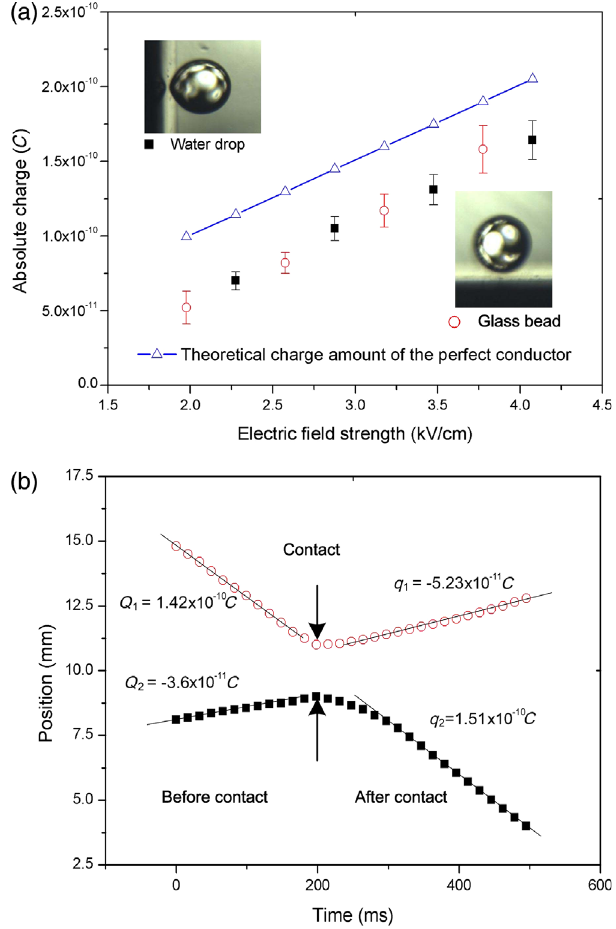
FIG. 1. Experiments within silicone oil: (a) Absolute value of the charges of a glass bead ( r ¼ 1 mm) and a water drop ( r ¼ 1 mm), bouncing between two high-voltage metal electro- des, after contact with the electrodes versus electric field strength (symbols). The charges are estimated from a balance between the viscous drag and Coulomb forces, while the solid line displays the theoretical charge of a perfectly conducting sphere ( r ¼ 1 mm) [39]. (b) Positions relative to the cathode and charges of two glass beads colliding between two high-voltage metal electrodes ( E ¼ 2 . 5 kV = cm) before and after their collision ( Q 1 þ Q 2 ≈ q 1 þ q 2 ).